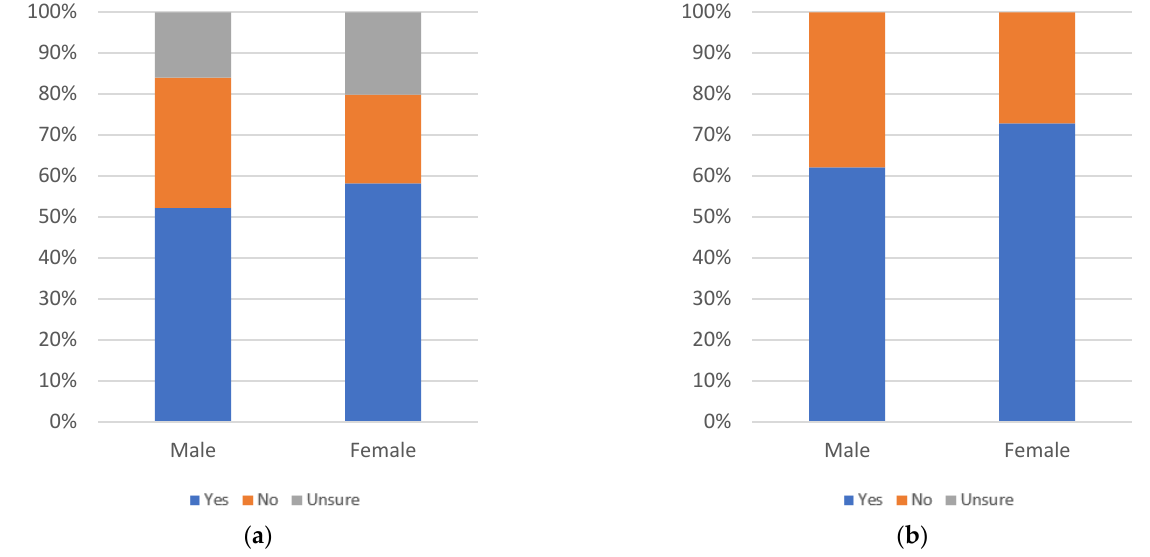
Figure 51. Label trustworthiness judging use, by gender: ( a ) with uncertain respondents (left) and ( b ) without uncertain respondents (right).